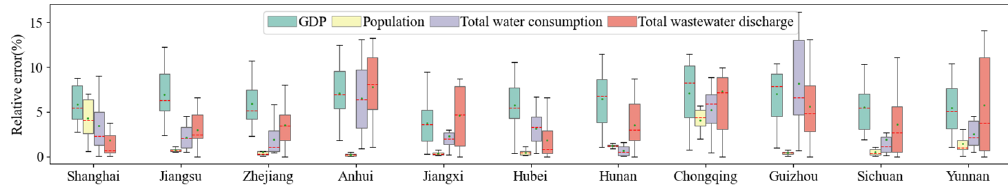
Water 2022 , 14 , x FOR PEER REVIEW Figure 3. Box diagram of relative error . Figure 3. Box diagram of relative error.